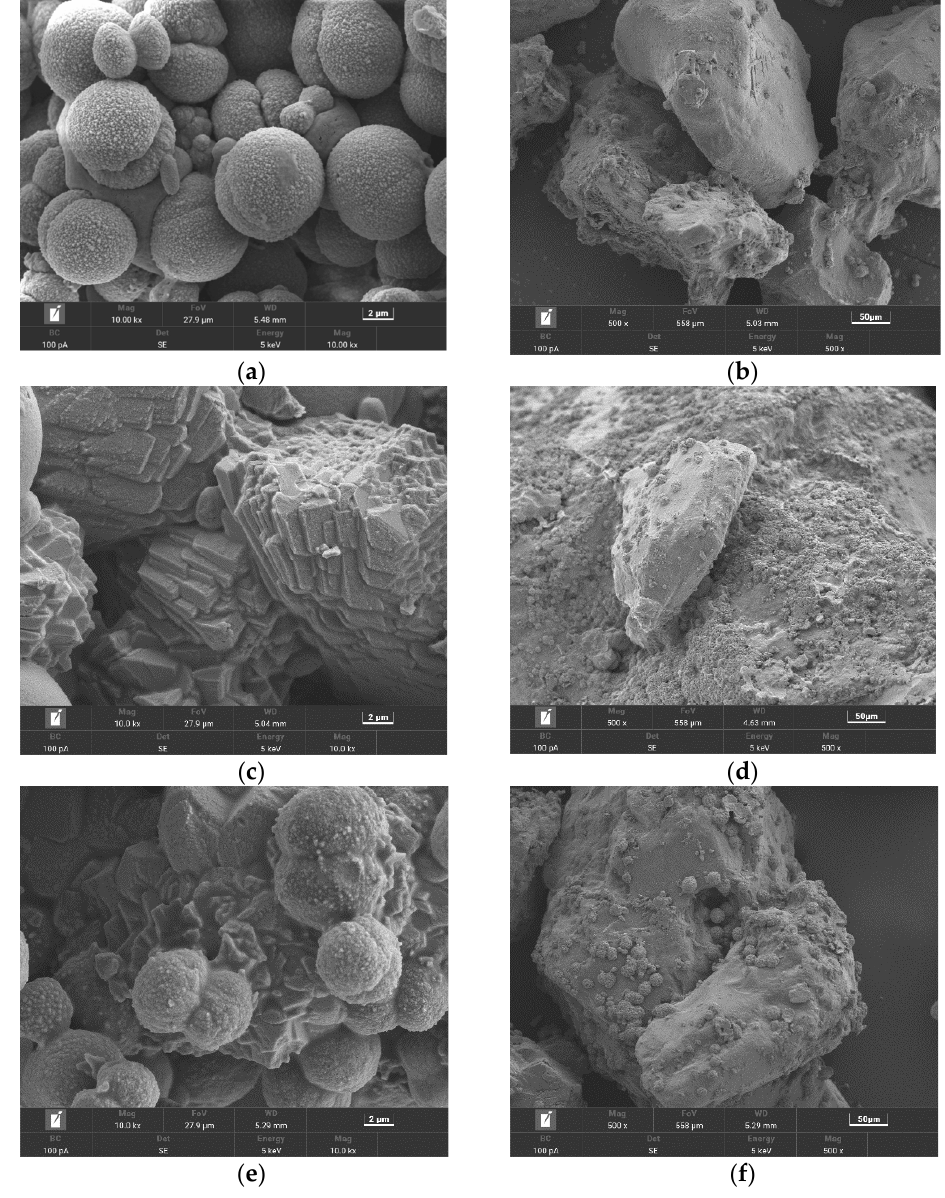
Figure 10. SEM images for sand treated by EICP at ( a ) 10000× magnification and ( b ) 500× magnification; for sand treated by EICP with sorbitol addition of 4% at ( c ) 10000× magnification and ( d ) 500× magnification; and for sand treated by EICP with sucrose addition of 4% at ( e ) 10000× magnification and ( f ) 500× magnification.